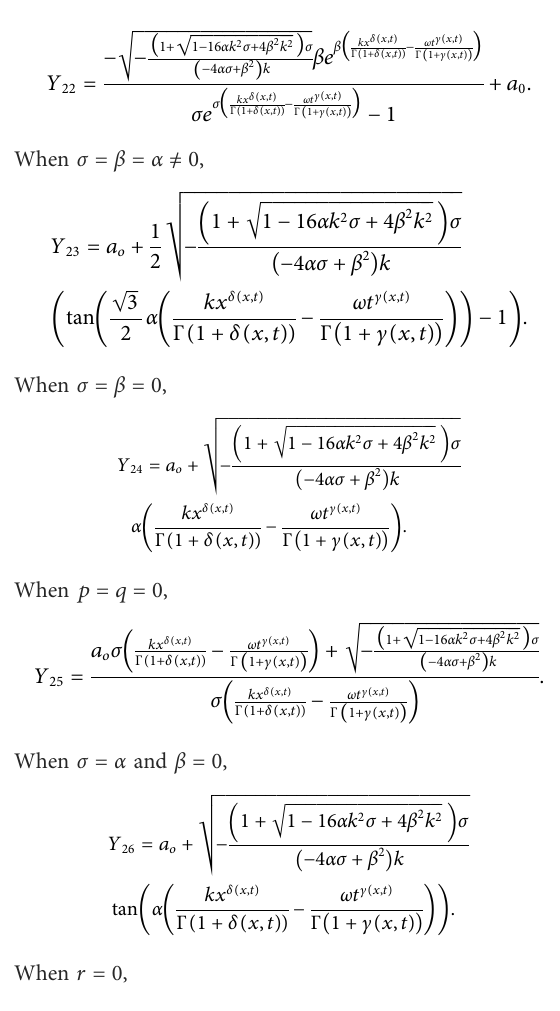
, γ ( x , t ) (cid:2) 2cos ( xt )+( xt ) 2